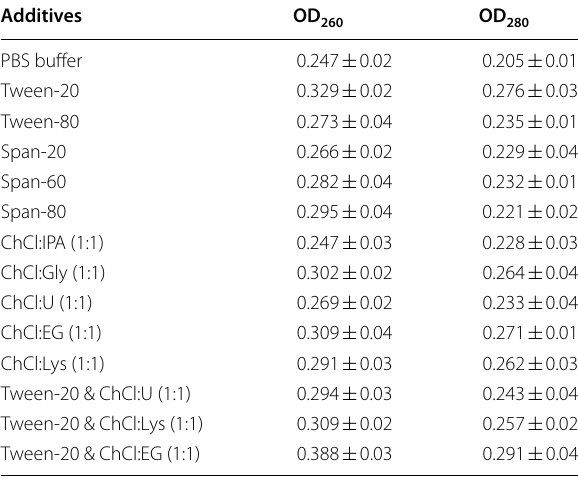
Table 5 The effects of various surfactants/NADESs on cell membrane